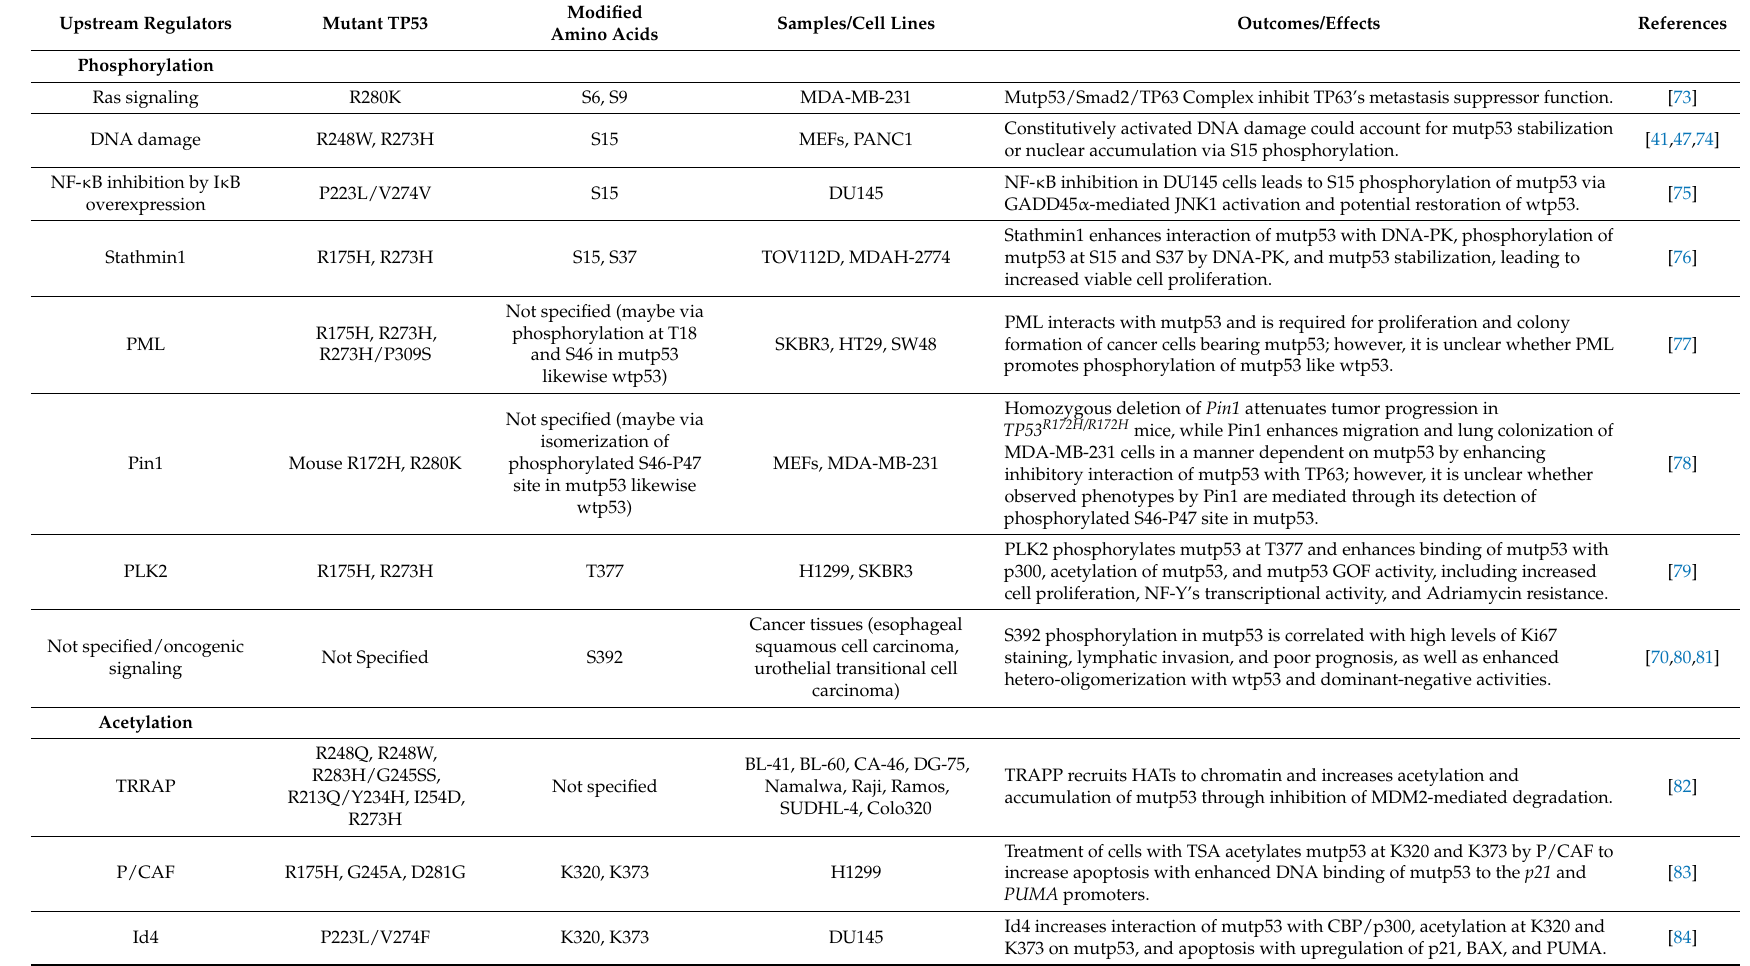
Table 1. Regulators that alter mutant TP53 stability and